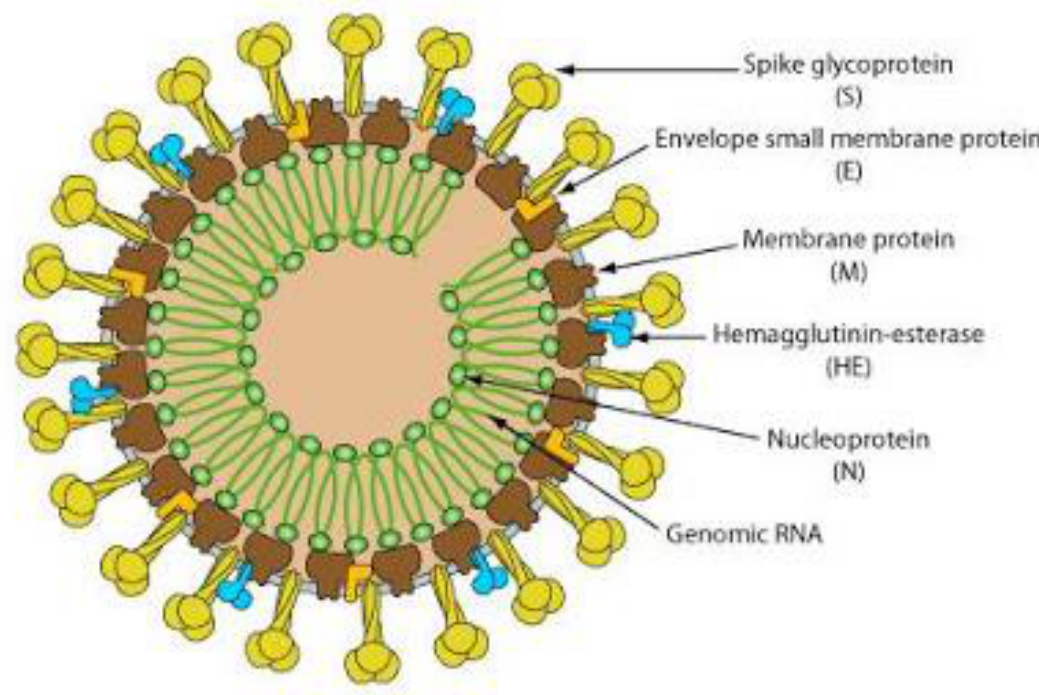
Figure 3. Diagram of a coronavirus